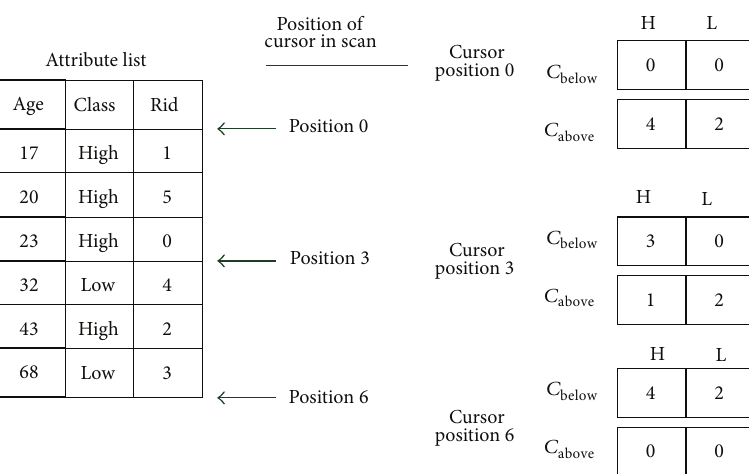
and 𝐶 of SPRINT above below